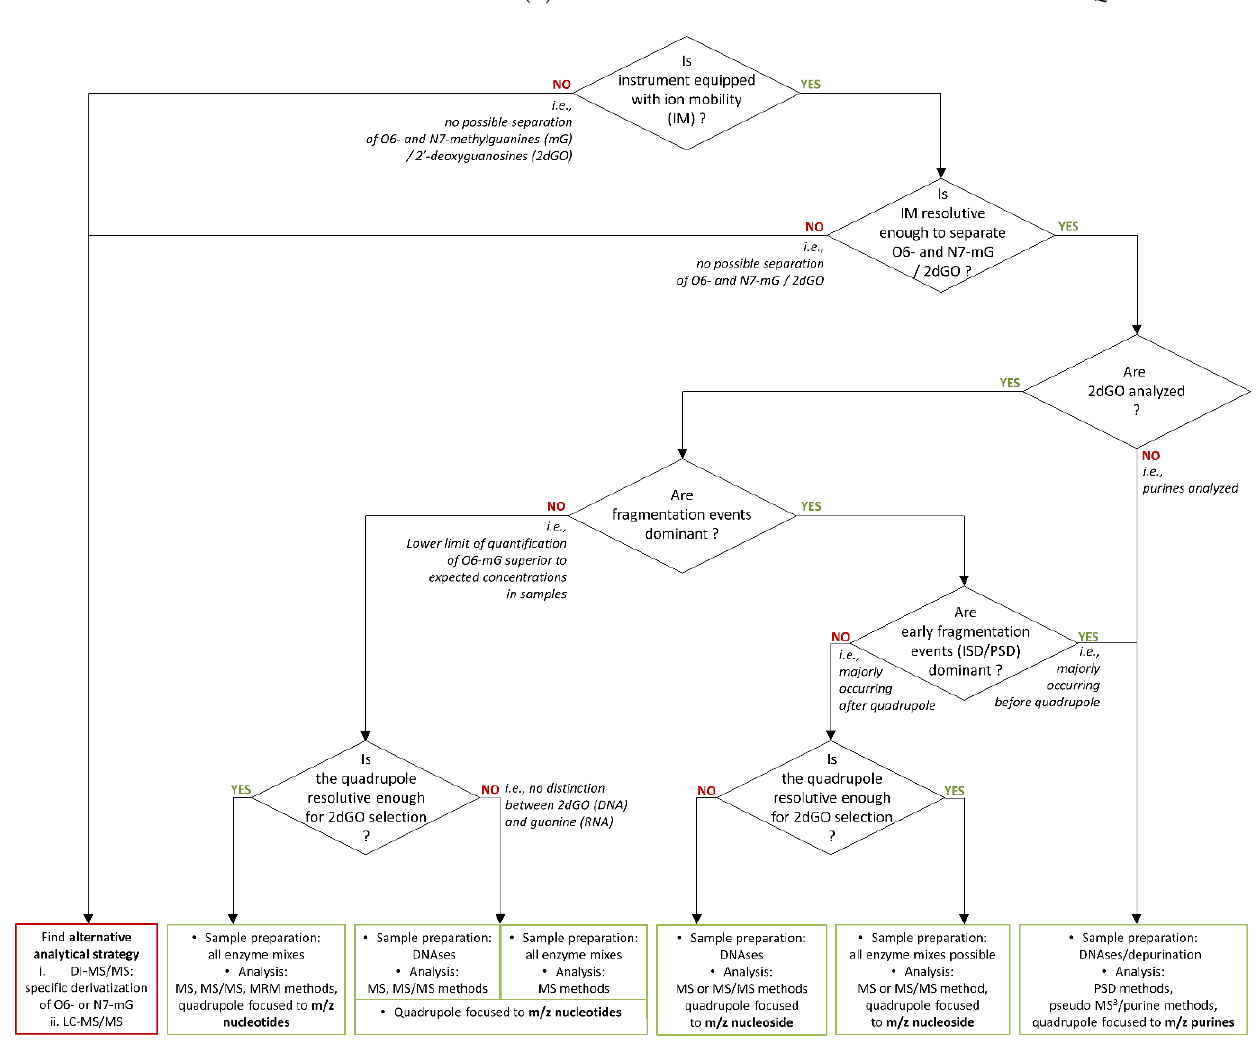
Figure 7. Decision algorithm for method development of a monitoring assay of temozolomide action through the quantification of O6-methylguanines (O6-mG) or O6-methyl- 2′ -deoxyguanosine (O6-m2dGO).